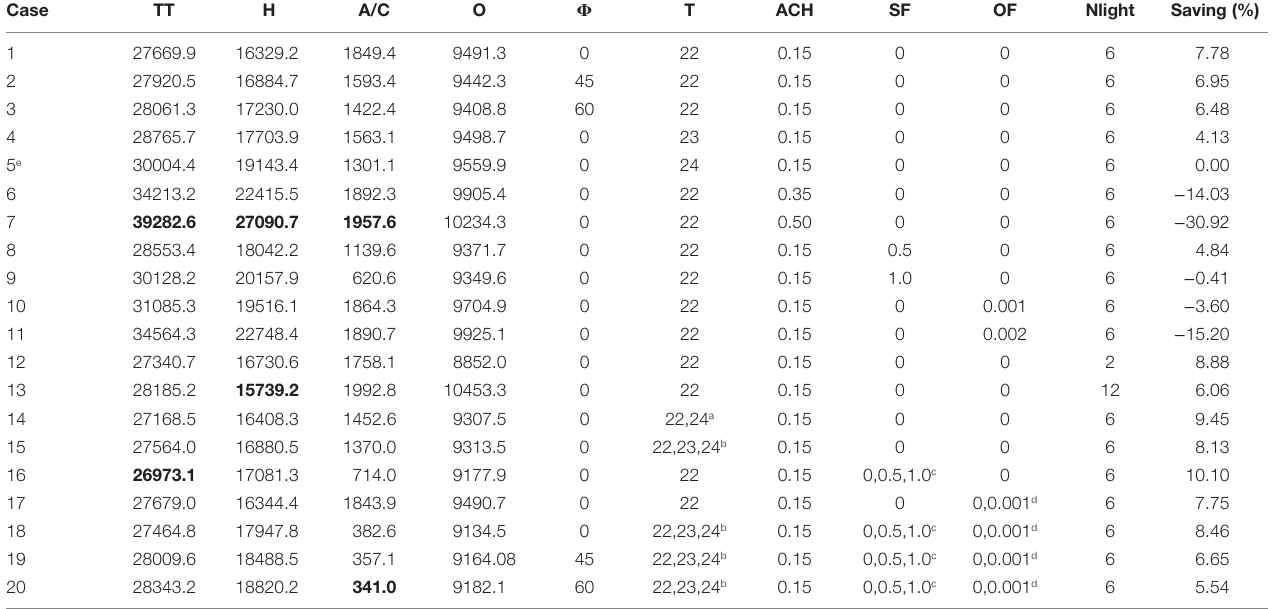
TaBle 6 | results for different cases.